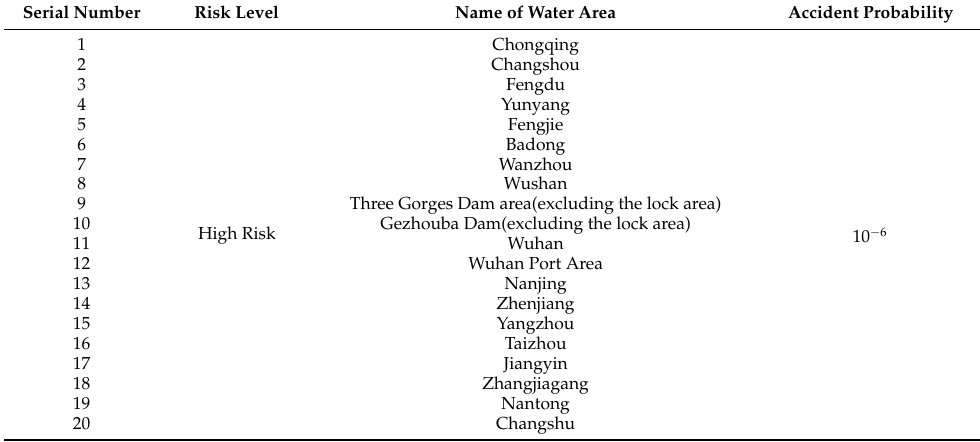
Table A3. Risk level classification of the Yangtze River mainline